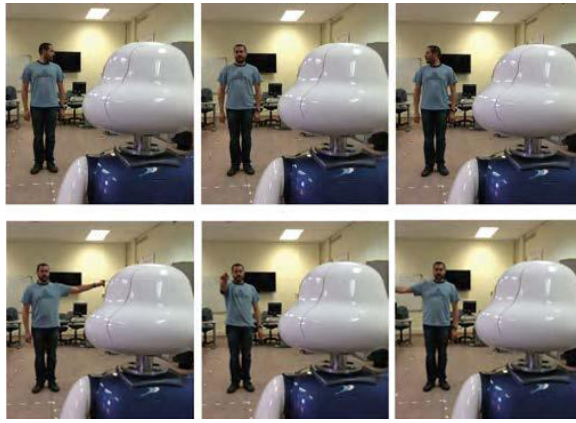
Figure 6: Image sequence from [20].